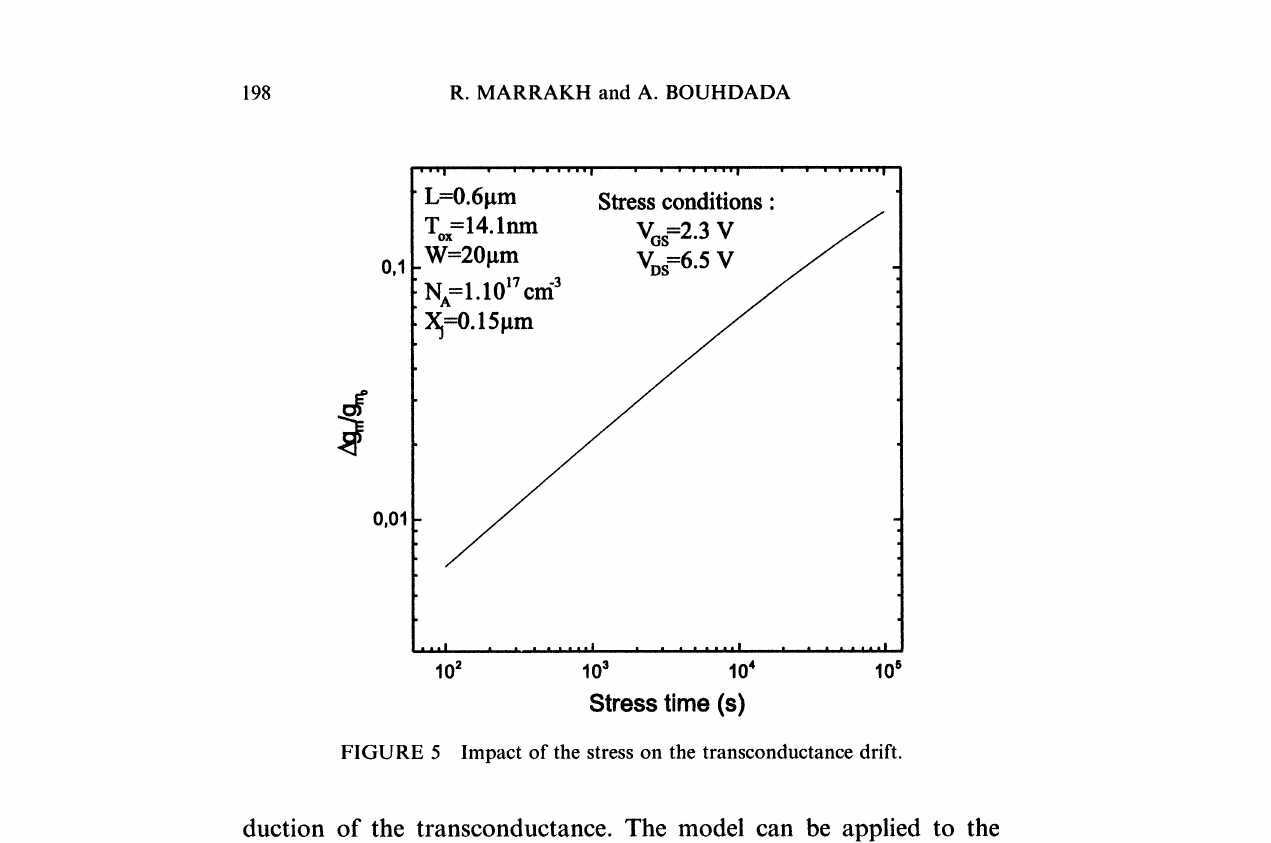
FIGURE 5 Impact of the stress on the transconductance